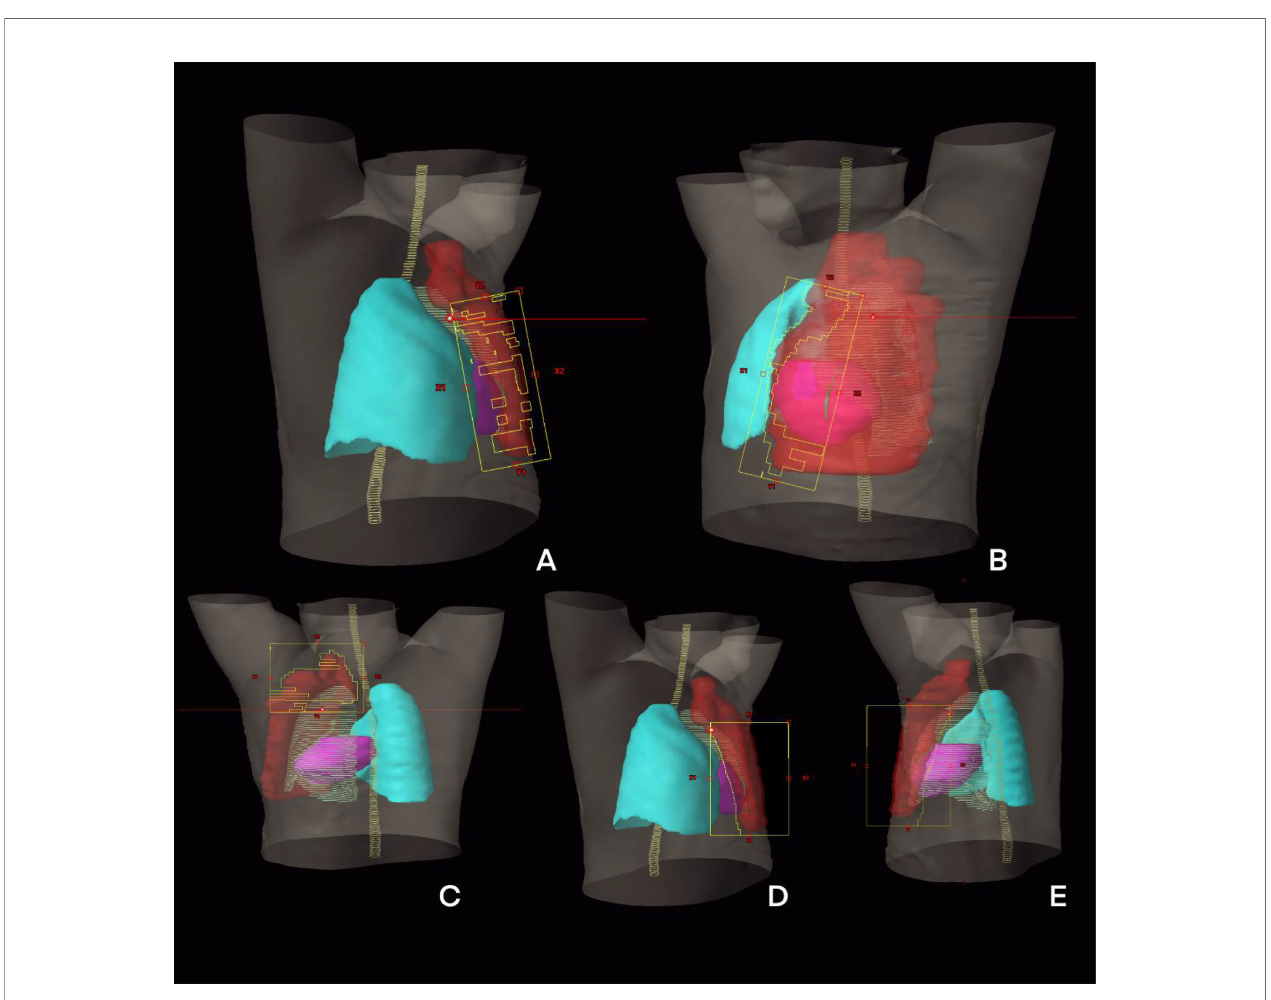
FIGURE 2 | The beam eye view of treatment planning design of H-VMAT technique: (A) An arc from 295° to 20°; (B) An arc from 40° to 150°; (C) Tangential fi eld one; (D) Tangential fi eld two; (E) An arc from 150° to